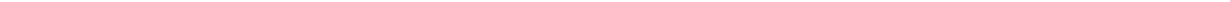
Fig. 4 Wnt/ β -catenin signaling controls col12a1a/b transcription and Col XII deposition in a spinal lesion site. a Wnt/ β -catenin pathway inhibition (IWR-1) results in lower expression of select collagen genes ( red box ) in the lesion site at 1 dpl, determined by in situ hybridization. b col12a1a and